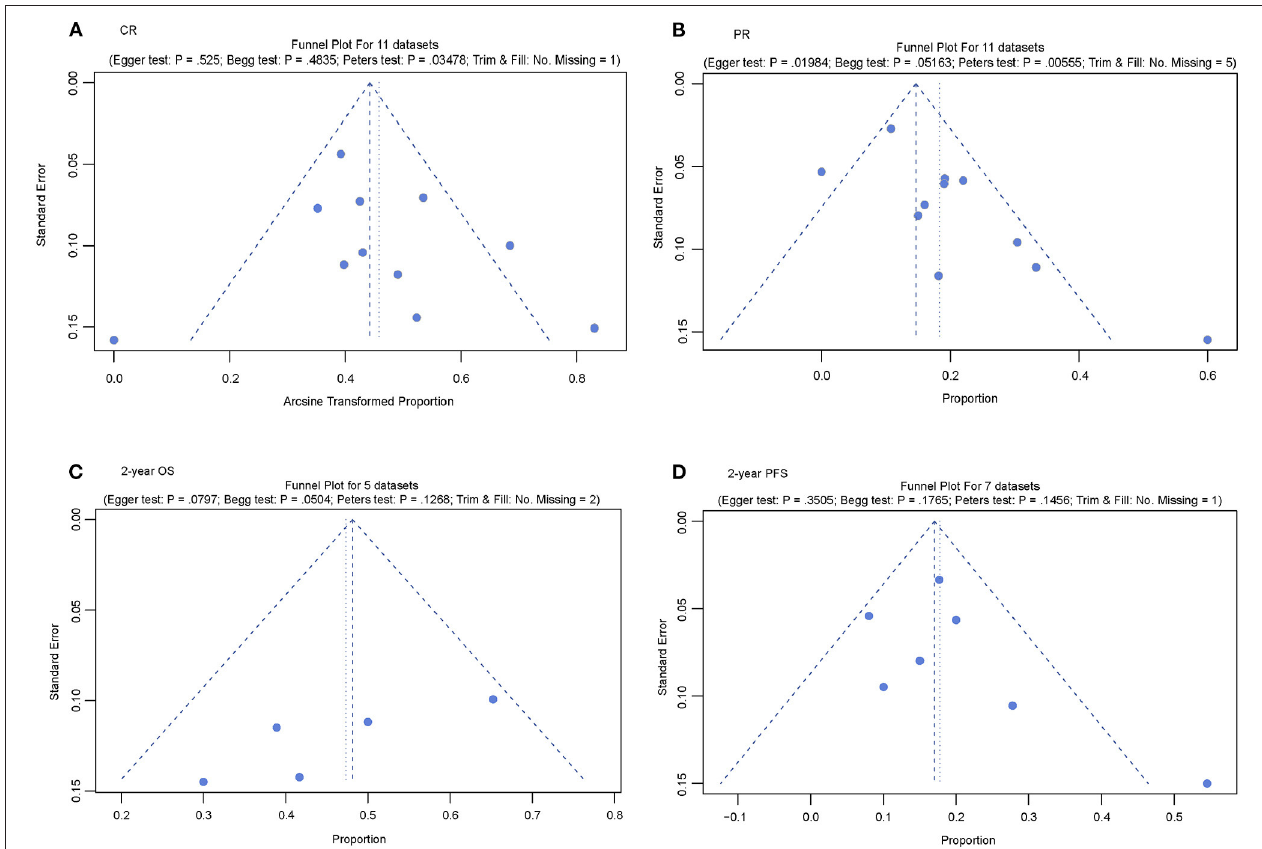
FIGURE 3 | Publication bias test of the included studies. (A) Funnel plot for complete response (CR); (B) Funnel plot for partial response (PR); (C) Funnel plot for 2-year overall survival (OS); and (D) Funnel plot for 2-year progression-free survival